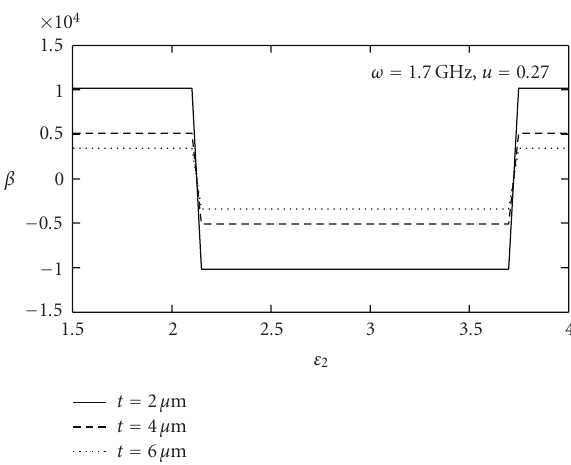
Figure 7: The normalized power flux versus dielectric constant at operating angular frequency and optical nonlinearity, ω = 1 . 7GHz, u = 0 . 27, for di ff erent dielectric film